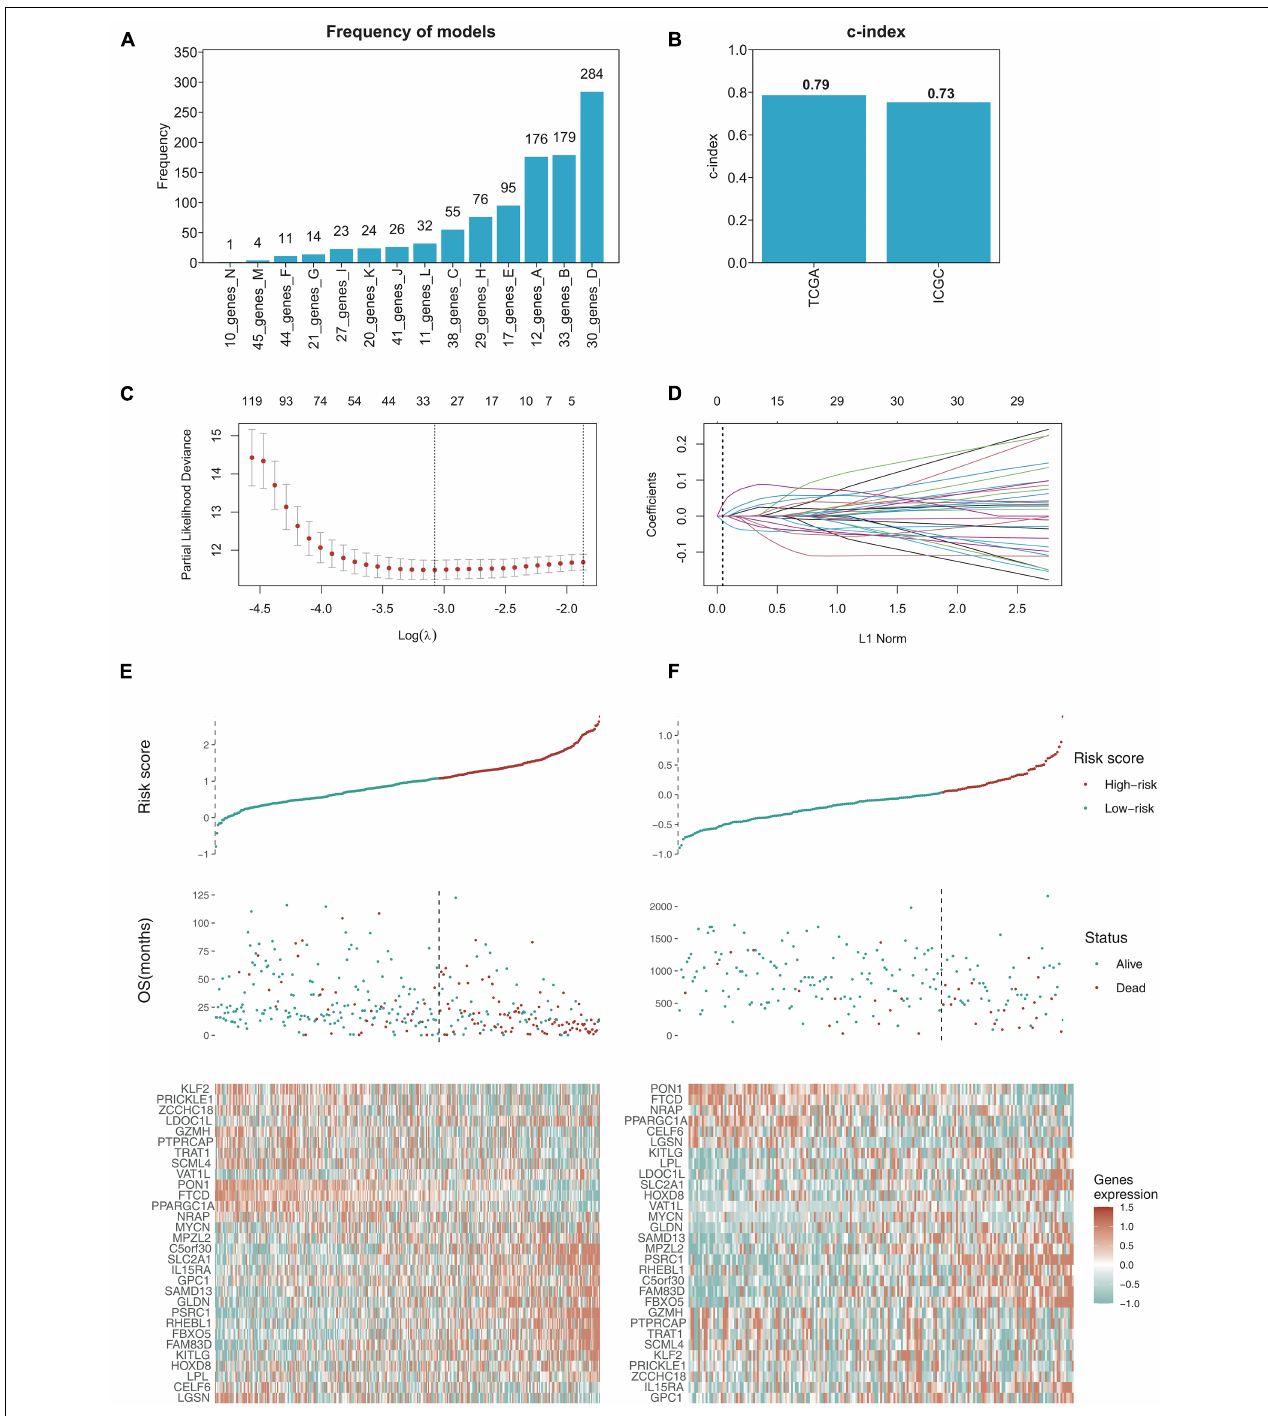
FIGURE 4 | Establishing the 30-gene prognostic model with LASSO regression analysis. (A) LASSO regression analysis performed the frequency of different gene combination models and finally determined the 30-gene signature for OS prediction. (B) C-index of 30-gene prognostic model was 0.79 in TCGA training cohort, while 0.73 in ICGC validation cohort. (C) LASSO coefficient profiles of the gene features. (D) Ten-time cross-validation for tuning parameter selection in the LASSO model. (E,F) The risk score distribution and survival status distribution of 30-gene prognostic model in TCGA training cohort and ICGC validation cohort, and the heat map of gene expression are shown below with color, red (high) and green